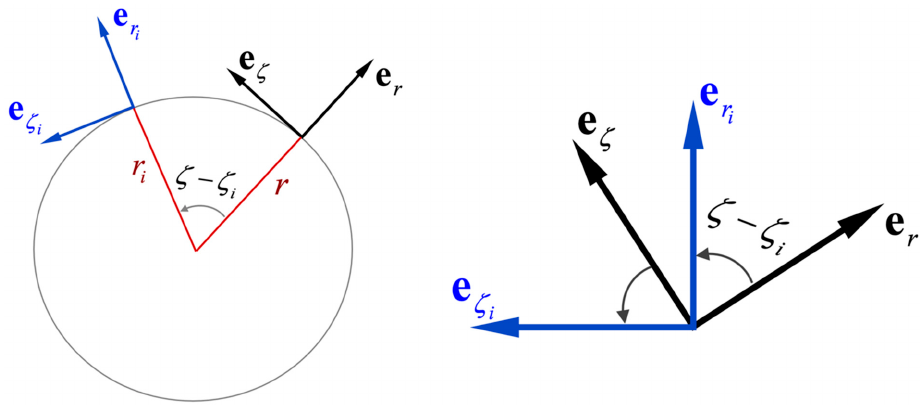
Figure 2. Two sets of coordinates and related unit vectors: the radial e r and the toroidal e ζ . The subscript i denotes variables on which the integration is performed, and ζ − ζ i is the angle between two basis sets.